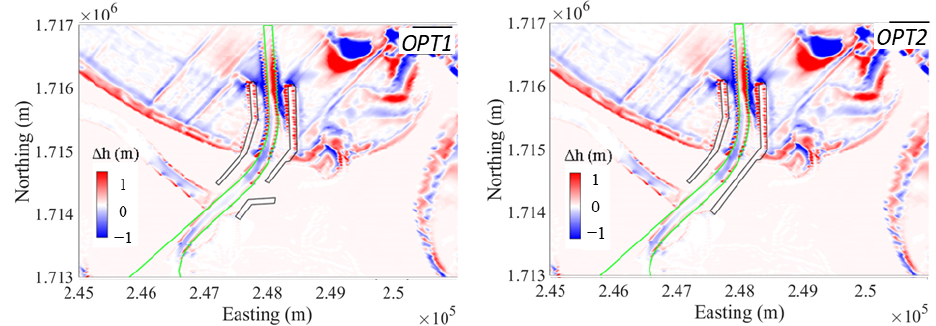
Figure 19. Bed level change in the area of Cua Lo after jetty construction.